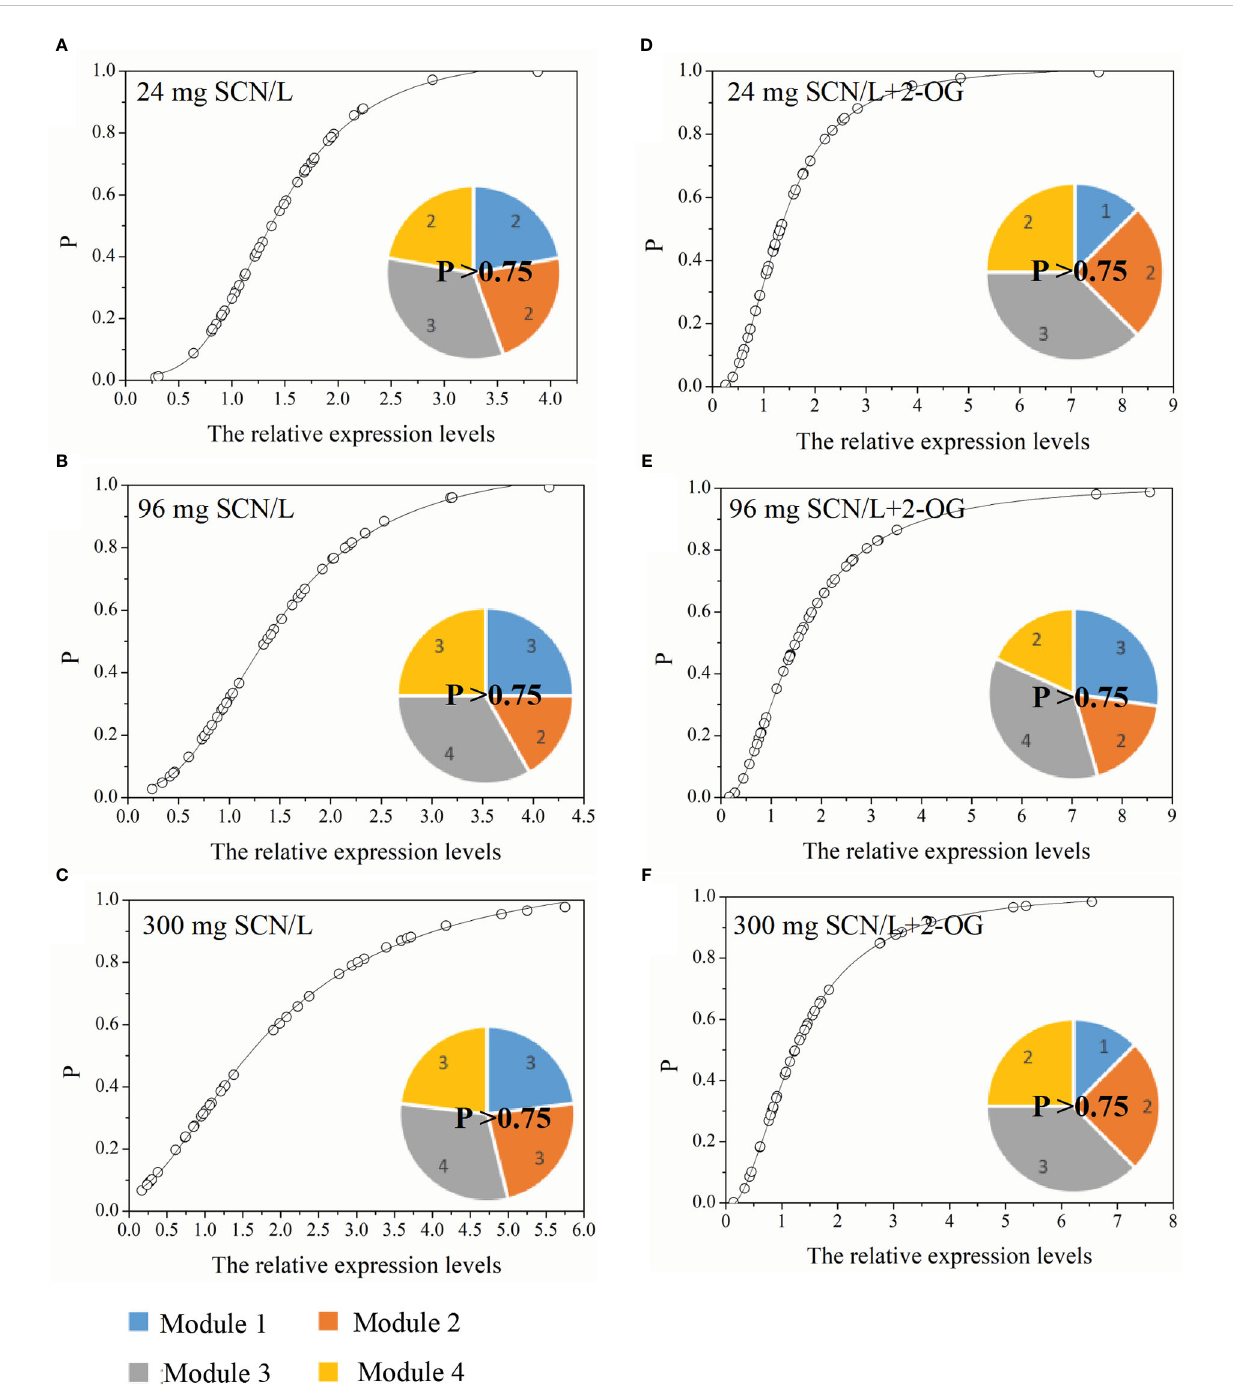
FIGURE 5 Occurrence P ( p > 0.75) of CNM-related genetic expression in rice shoots under (A) 24 mg SCN/L, (B) 96 mg SCN/L, and (C) 300 mg SCN/L treatments and under (D) 24 mg SCN/L + 2-OG, (E) 96 mg SCN/L + 2-OG, and (F) 300 mg SCN/L + 2-OG treatments. CNM, carbon and nitrogen metabolism; 2-OG,